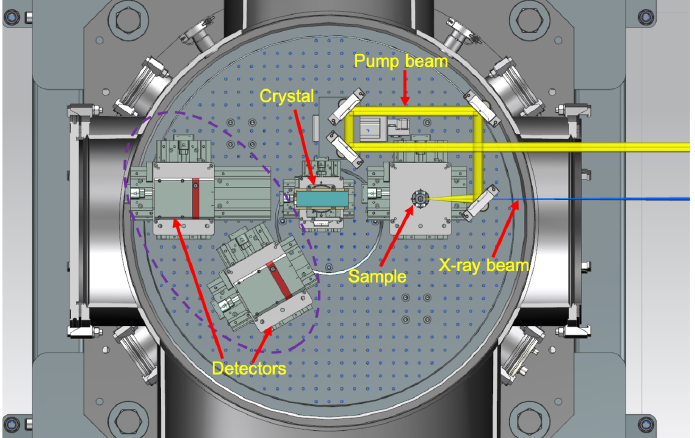
Figure 10. Schematic of the interior of the Gammatron user station, showing the setup for simultane- ous time-resolved X-ray spectroscopy and diffraction experiments.